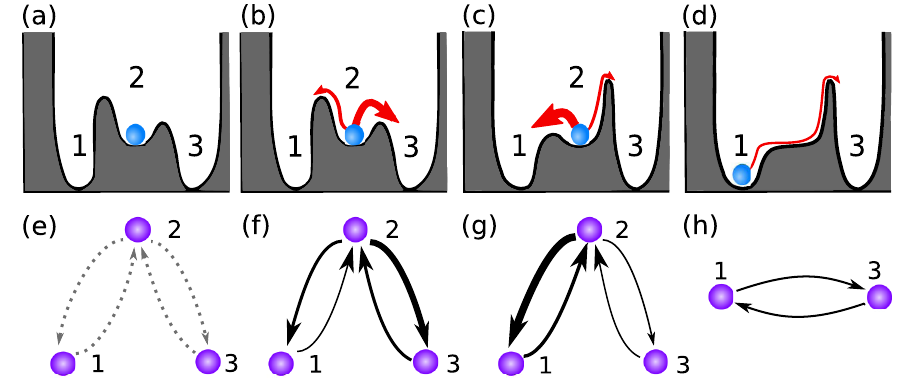
FIG. 1. Control of the response to noise illustrated for a multiwell quasipotential. (a) Without noise the state of the system is fixed and will not change over time. (b) In the presence of noise the state of the system wanders within the attraction basin and will be eventually ejected into the attraction basin of another stable state. For small noise such transitions are exponentially more likely to occur through the lowest barrier, even though other transitions are also possible in principle. (c) Using OLAC on a set of tunable parameters, we can alter the quasipotential to produce a desired response to noise, in this case tailored to increase transitions from state 2 to state 1 and to reduce transitions to state 3. (d) If desired, OLAC can also find combinations of tunable parameters that can alter the quasipotential in order to eliminate a stable state through a bifurcation; in this illustration state 2 is eliminated, in favor of state 1. (e) – (h) NEST for each of the quasipotentials in (a) – (d), respectively, where the nodes represent stable states and the continuous edges represent transition rates. A wider continuous edge indicates a higher transition rate. The dotted edges in (e) indicate transitions that could occur in the presence of